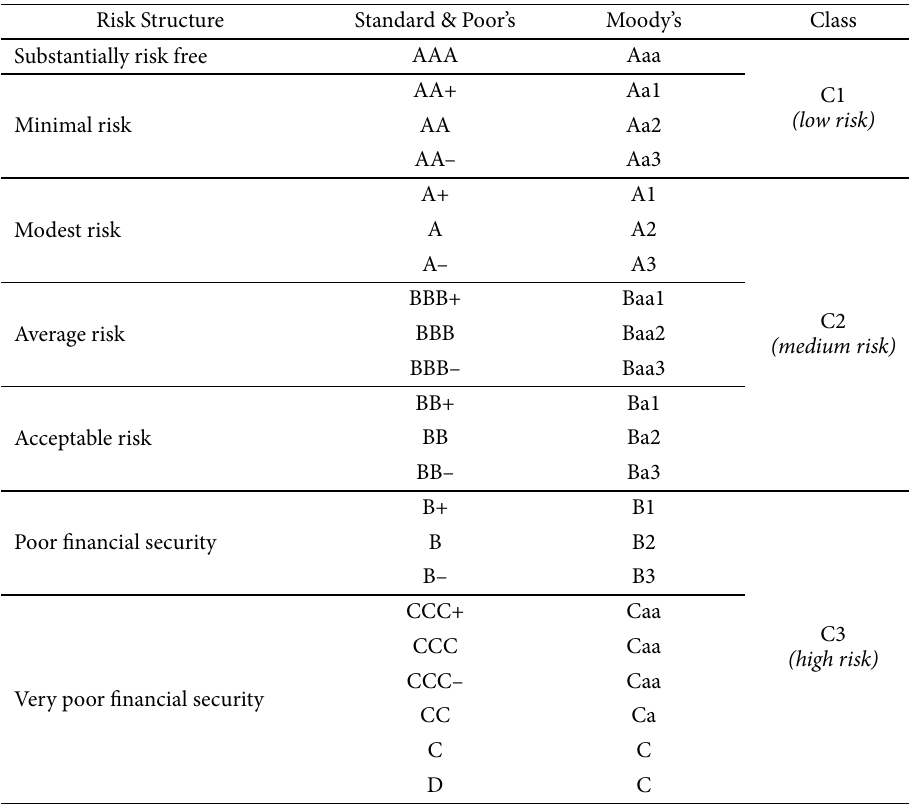
table 1. classification of standard & poor’s and moody’s ratings